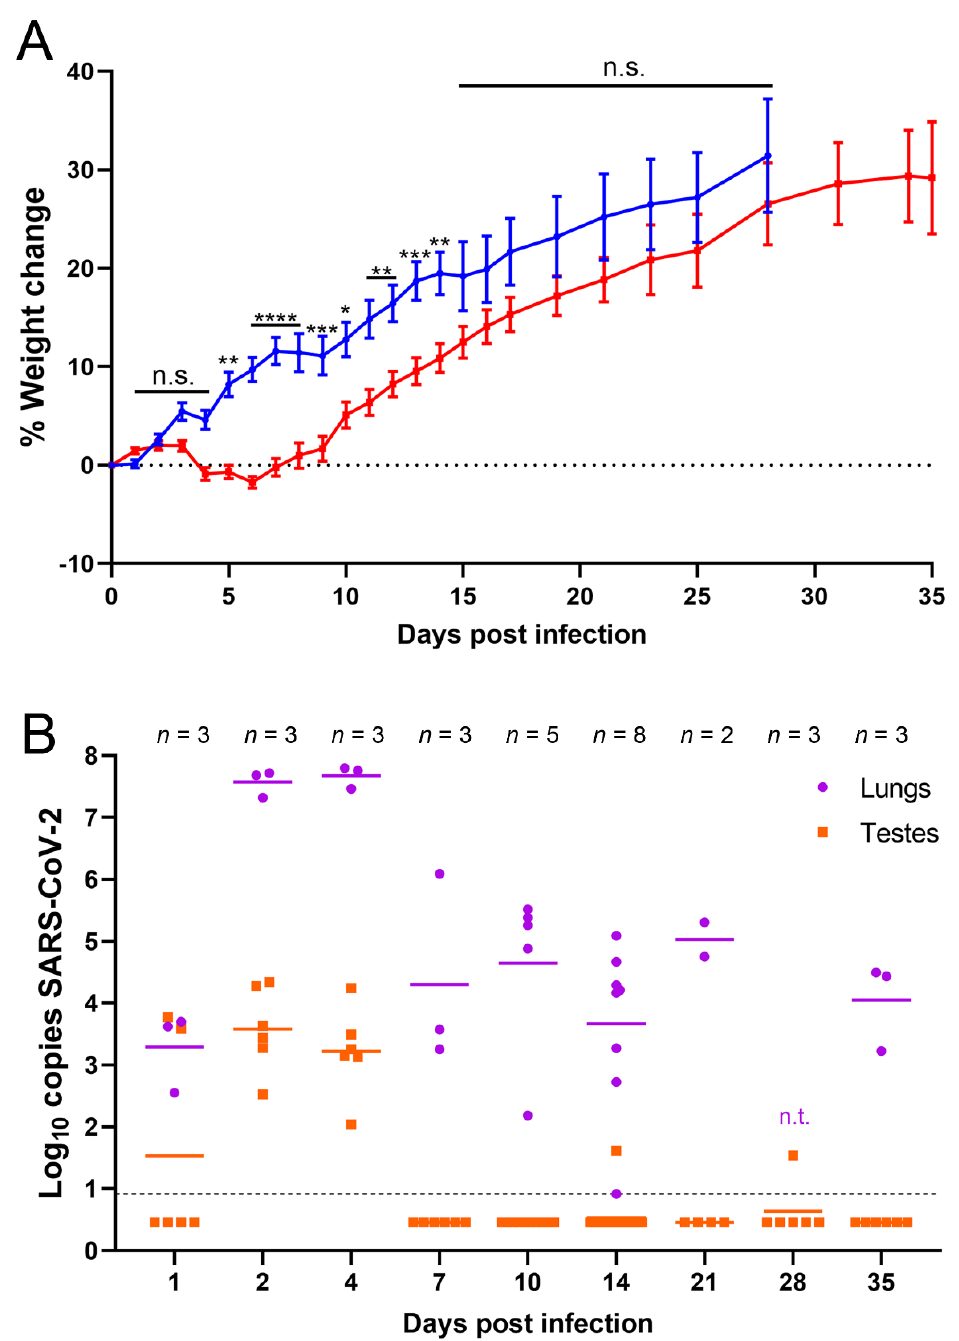
Figure 1. SARS-CoV-2 RNA was detected in testes of infected hamsters. ( A ) Percent weight change of infected (red, target dose 1 × 10 5 PFU) and uninfected (blue, PBS) hamsters. Individual hamsters’ data are plotted and the line represents the average. Weight data is from one experiment out of three done. Error bars represent the standard error of the mean. Asterisks represent p values from statistical comparisons of infected vs uninfected groups at each timepoint: * p < 0.05, ** p < 0.01, *** p < 0.001, **** p < 0.0001. n.s. stands for not significative, p ≥ 0.05; ( B ) RT-qPCR results from homogenized lung (purple) and testes (orange). n.t. indicates samples that were not tested by RT-qPCR. Samples below the dashed line were undetectable after 40 cycles. Undetectable samples were represented as half of the lowest sample detected (0.46). Panel B shows data of three experiments